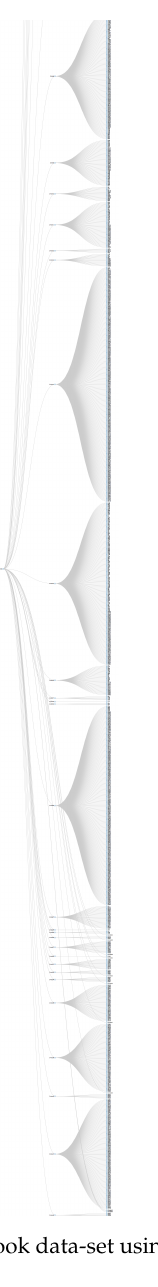
Figure A5. Representation of the Facebook data-set using circle packing visualization.